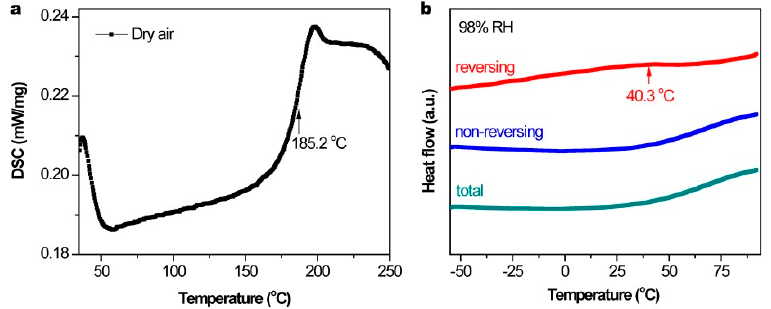
Figure 8. ( a ) DSC thermogram of PIL-Br equilibrated under dry conditions. ( b ) TMDSC thermogram of PIL-Br equilibrated under 98% relative humidity levels (RH): total, reversing and non-reversing heat-flow signals.